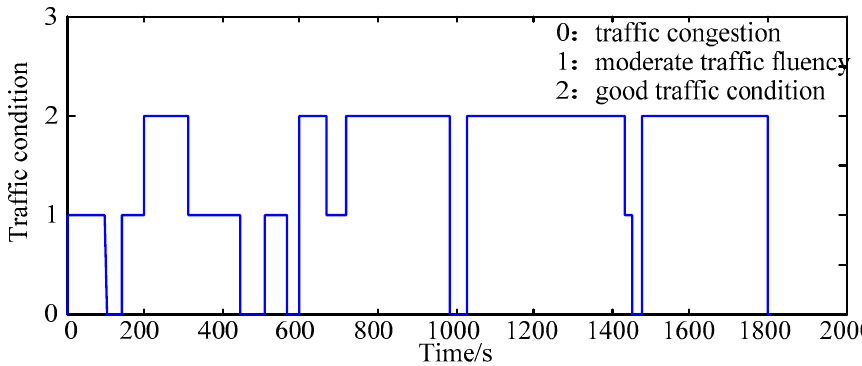
Figure 3. Traffic condition of the World Light Test Procedure (WLTP) driving cycle.